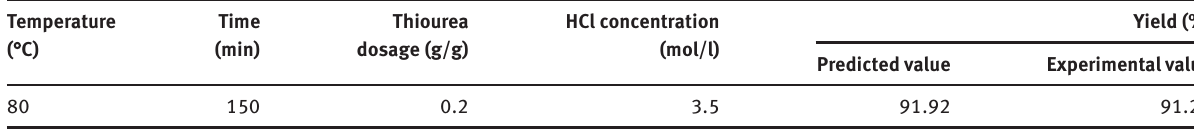
Table 6: Predicted and experimental values of the responses at optimum conditions.